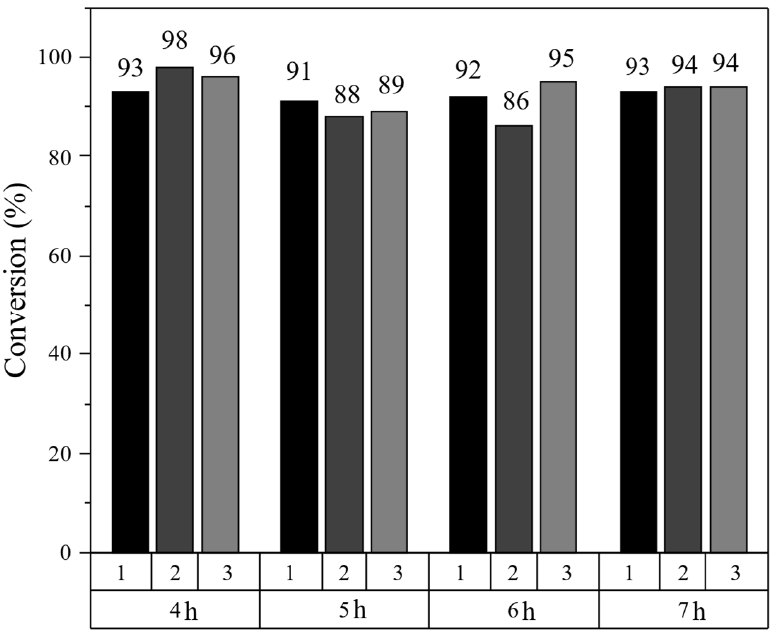
Figure 9. Reuse of PMoV 2 at 4 h, 5 h, 6 h, and 7 h. The black bar represents the first cycle, the dark-gray bar the second, and finally, the light-gray bar the third, for each time.